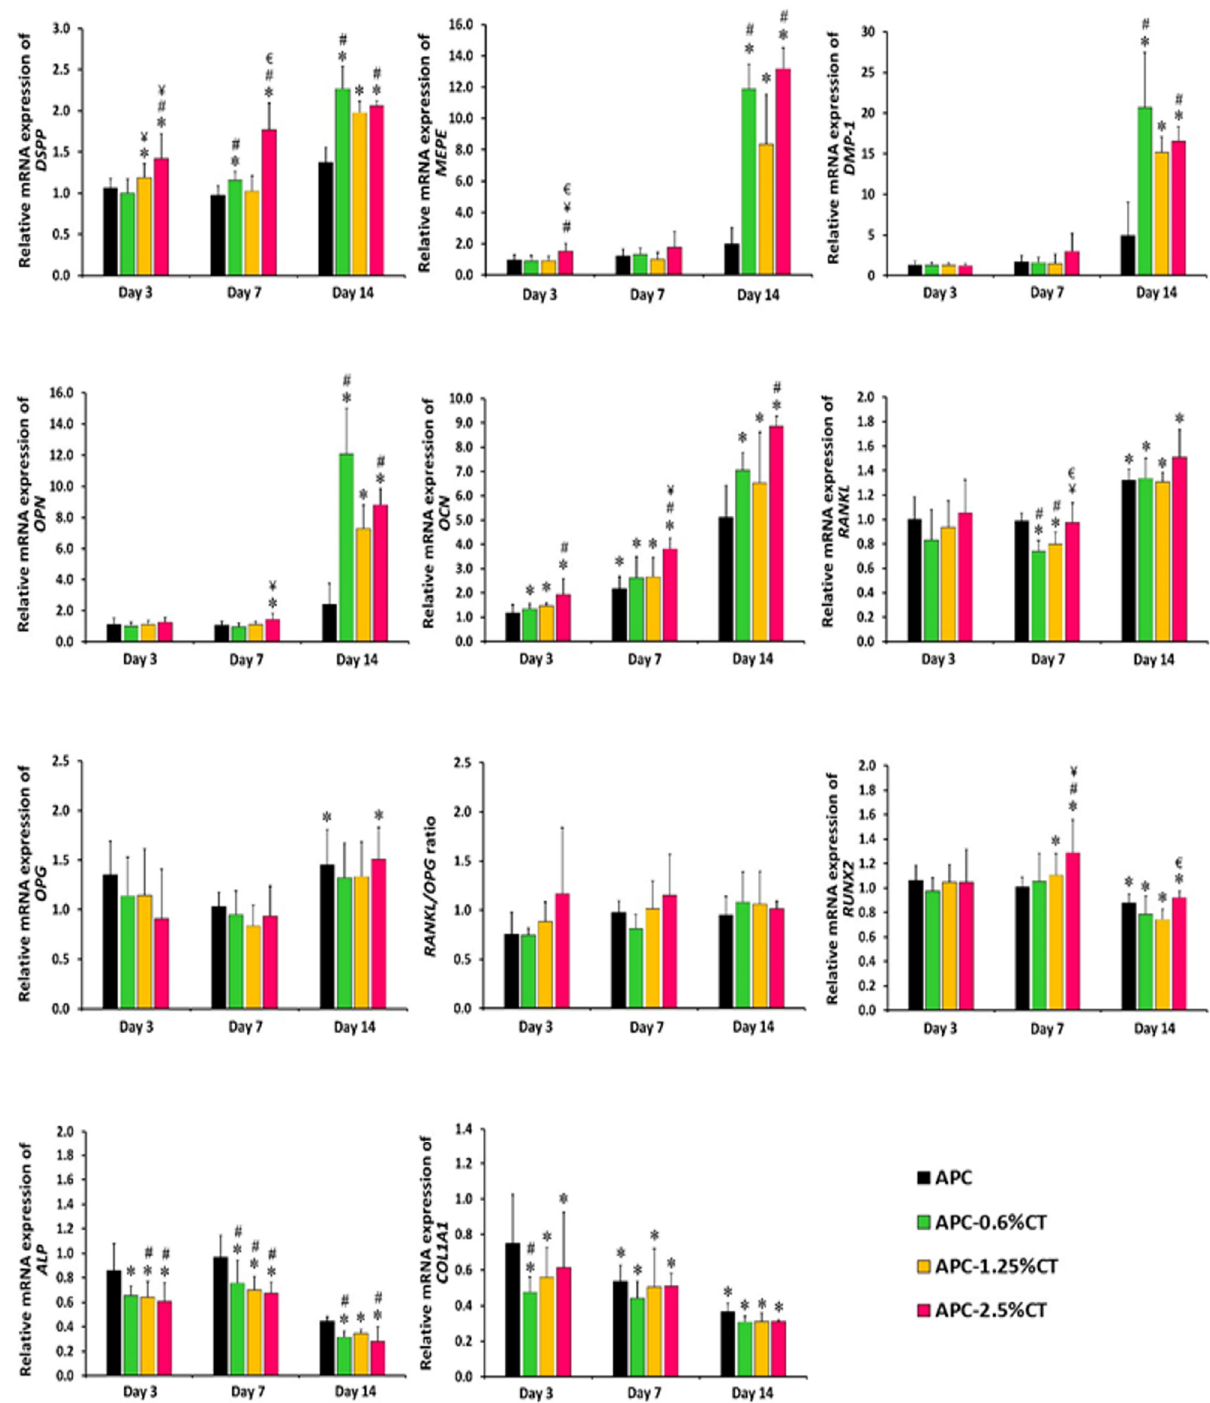
Figure 4. Real-time PCR analysis of relative mRNA expression of dentinogenic/osteogenic-related markers, including DSPP, MEPE, DMP-1, OPN, OCN, OPG, RANKL, RUNX2, ALP and COL1A1 genes in SHED exposed to APC and APC-CT materials after 3, 7 and 14 days. The relative gene expression of target genes was normalized against the internal control genes (GAPDH and β -actin) and relative to untreated control. The control was set at 1 and the data represent mean ± SD of three samples in three independent experiments ( n = 3). * p < 0.05 vs. control, # p < 0.05 vs. APC, ¥ p < 0.05 vs. APC-0.6%CT and € p < 0.05 vs. APC-1.25%CT.